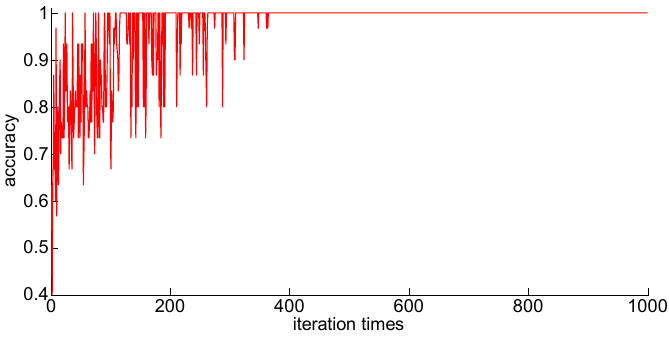
Figure 13. One hundred twenty-five training samples of the neural network. Algorithms 2018 , 11 , x FOR PEER REVIEW